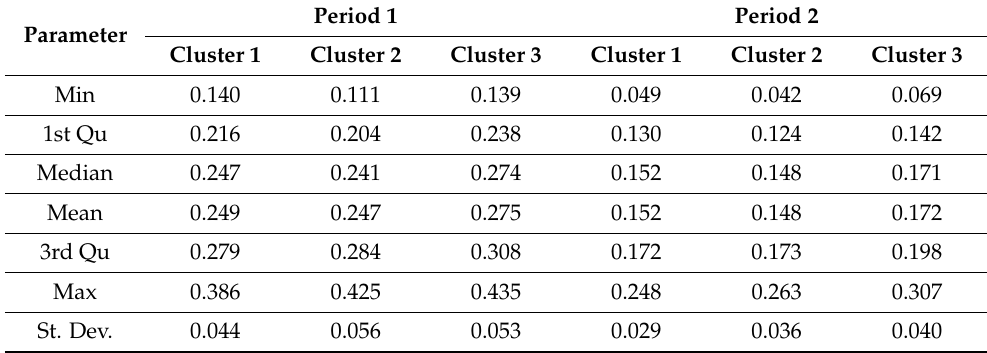
Table 14. Descriptive statistics of the voltage unbalance factor k u2 at the tested measuring point.